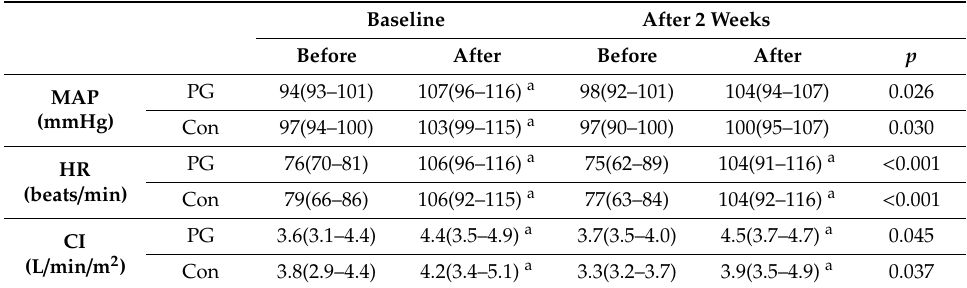
Table 4. Changes in systemic hemodynamic parameters during the study